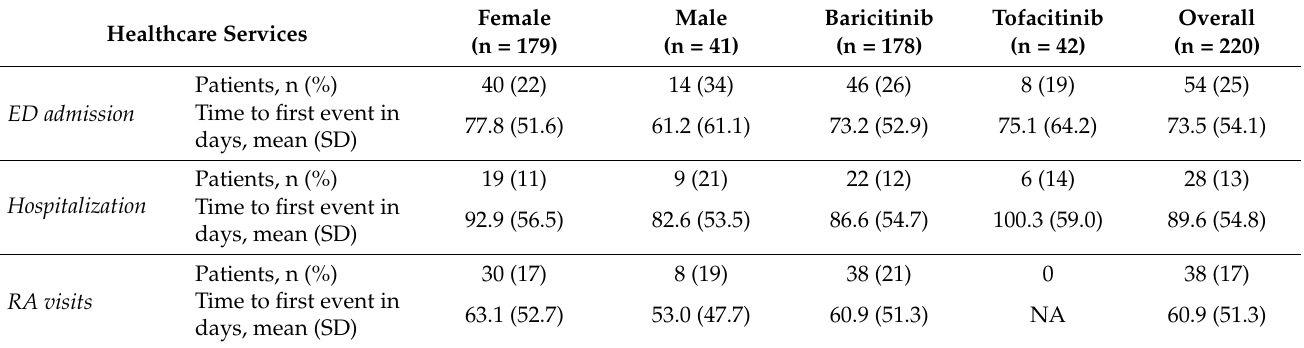
Table 6. Distribution of patients with at least 1 healthcare service admission and time to the first admission in the 6 months of